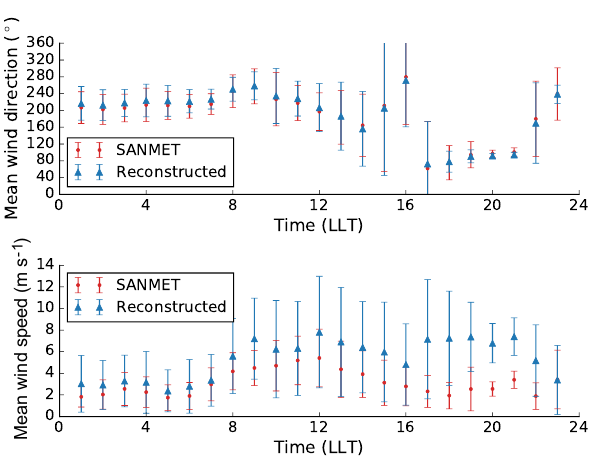
Figure 21. Wind direction and speed during 1h at the midday of sol 41 ( L s 116 ◦ ). 97–118 ◦ ). = =